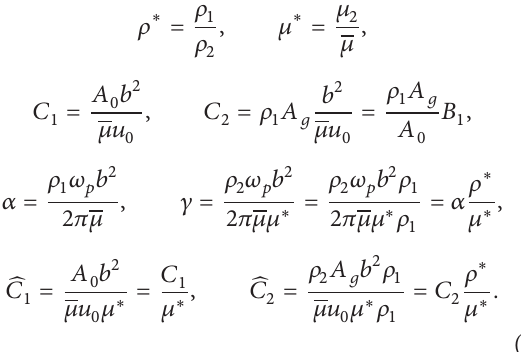
Figure 7: Velocity profiles at three arterial locations (𝑟 1 ,𝑟 2 ,𝑟 3 ) : for 𝑚 = −1/4 and under different slip parameters 𝑙 𝑏 and artery radii (a) 𝑟 = 0.15 cm; (b) 𝑟 = 0.50 cm. In the Figure, the graphs on the left column correspond to 𝑙 correspond to 𝑙 𝑏 = 2